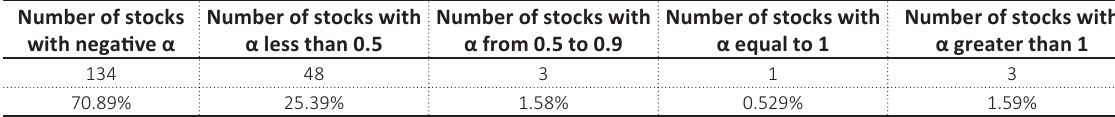
Table 4. Correlation between stock returns and benchmark index returns as of 2019 Number of stocks Number of stocks Number of stocks with negative γ with γ less than 0.5 with γ from 0.5 to